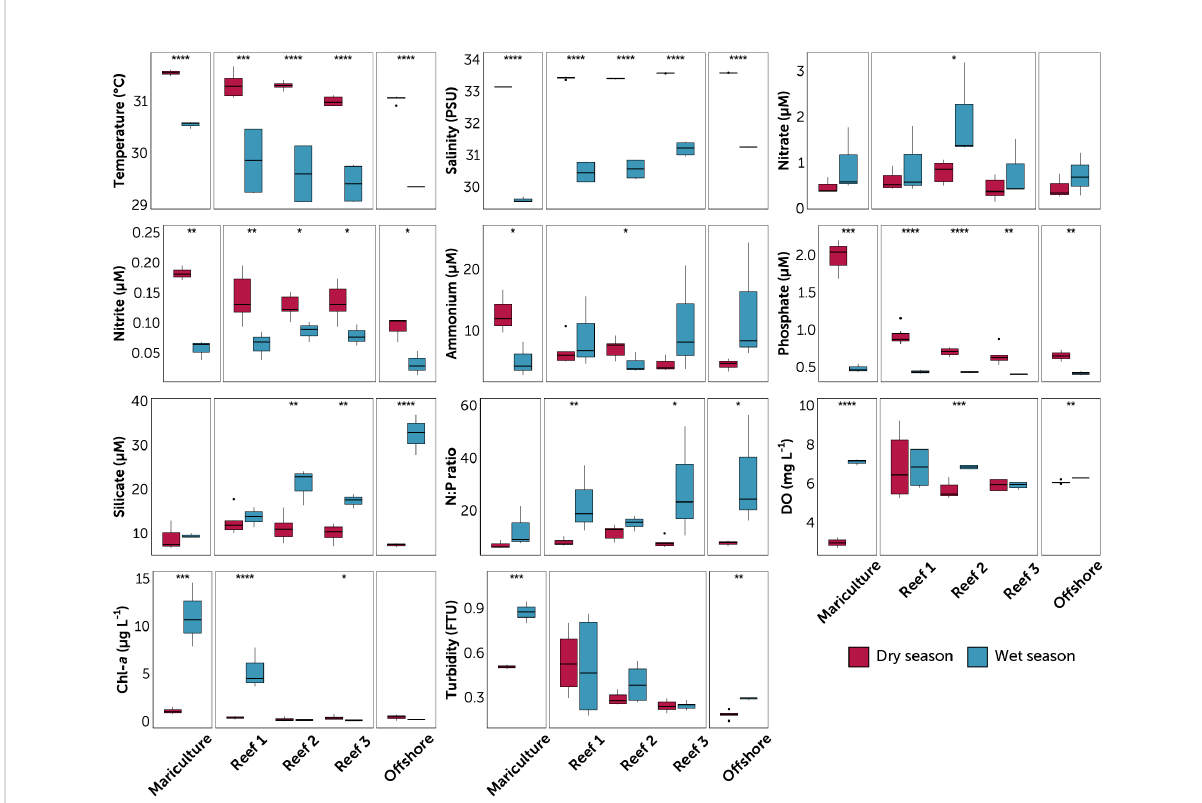
FIGURE 2 Water quality parameters at the sampled stations, grouped by station type (mariculture, three reefs, and offshore). Reefs are arranged from nearest (Reef 1) to farthest (Reef 3) from the mariculture station. Data are divided into dry (red) and wet season (blue) for each station. Value pairs within each station that share a symbol (* p ≤ 0.05; ** p ≤ 0.01; *** p ≤ 0.001; **** p ≤ 0.0001) denote signi fi cant difference between seasons (t-test of log-transformed values). Circles are outliers > 1.5x the inter-quartile